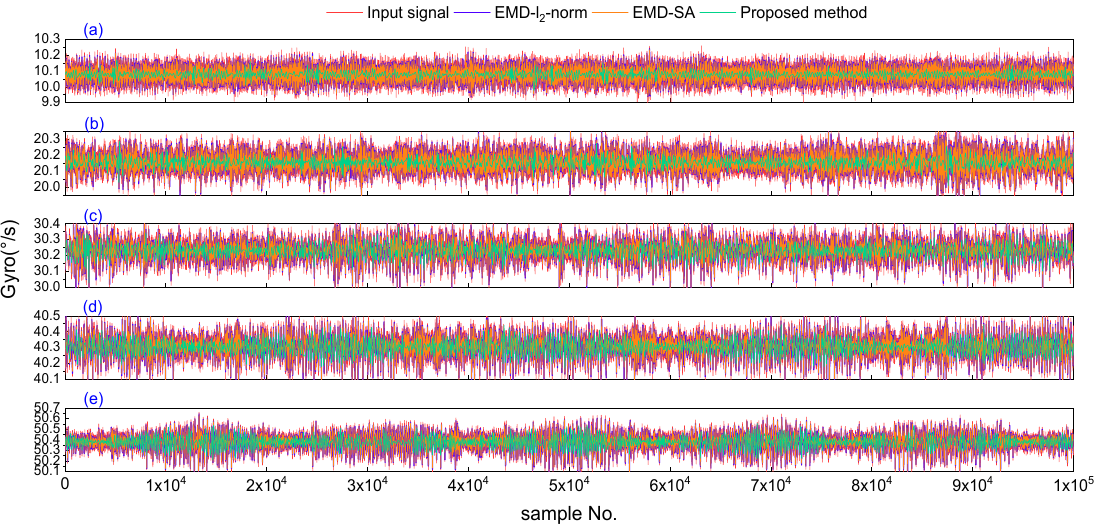
Table 2. Comparison of root mean square error (RMSE) and standard deviation (STD) for the denoising results of dynamic signals with different rotational speeds. Rotational Speed